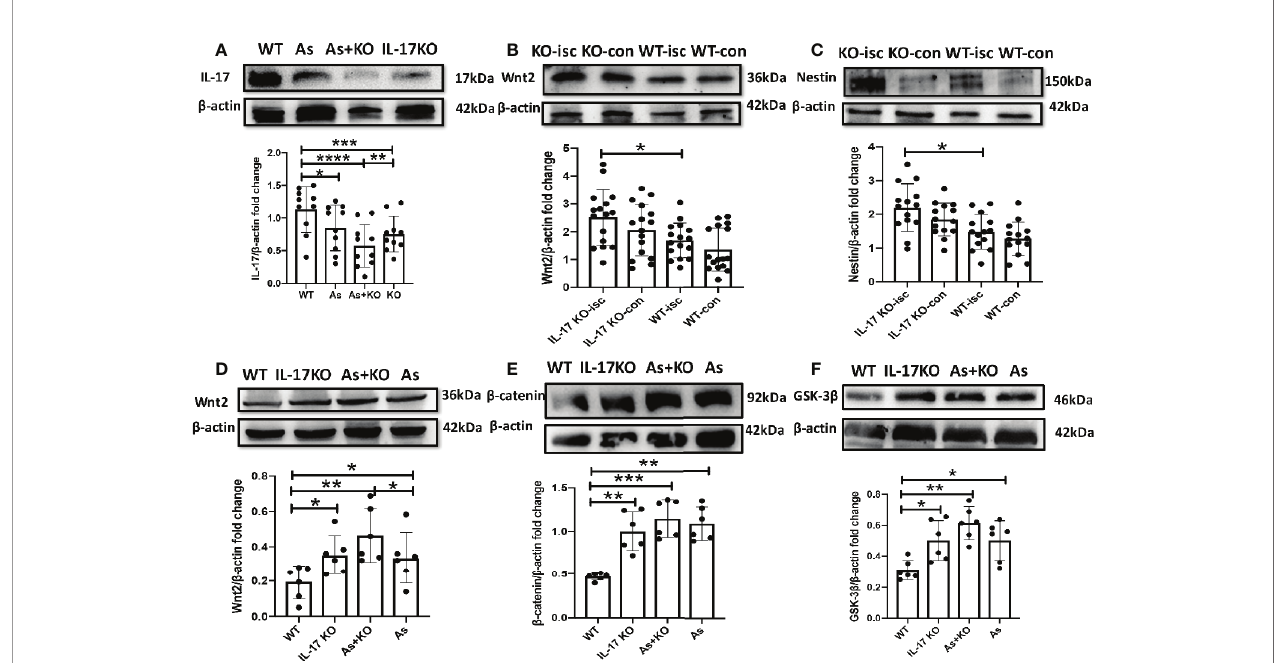
FIGURE 6 | Nestin and Wnt signal pathway protein expression is upregulated by administering As IV or knocking out IL-17, and IL-17 expression is downregulated by As IV. (A) IL-17 expression was downregulated by giving As IV or knocking out IL-17. n = 3, *p < 0.05, **p < 0.01, ***p < 0.001, ****p < 0.0001. (B, C) Wnt2 and Nestin expression in the ipsilateral hippocampus was increased in IL-17 KO mice compared with WT mice at 3 dpi. n = 3, *p < 0.05. (D – F) Wnt signal pathway protein-Wnt2, b -catenin and GSK-3 b was upregulated by treating with As IV or knocking out IL-17. n = 3, *p < 0.05, **p < 0.01, ***p < 0.001. IL, interleukin; KO, IL- 17 knockout; WT, wild type; Isc, ischemic hippocampus; Con, contralateral hippocampus; As, Astragaloside; GSK-3 b , Glycogen synthase kinase 3.